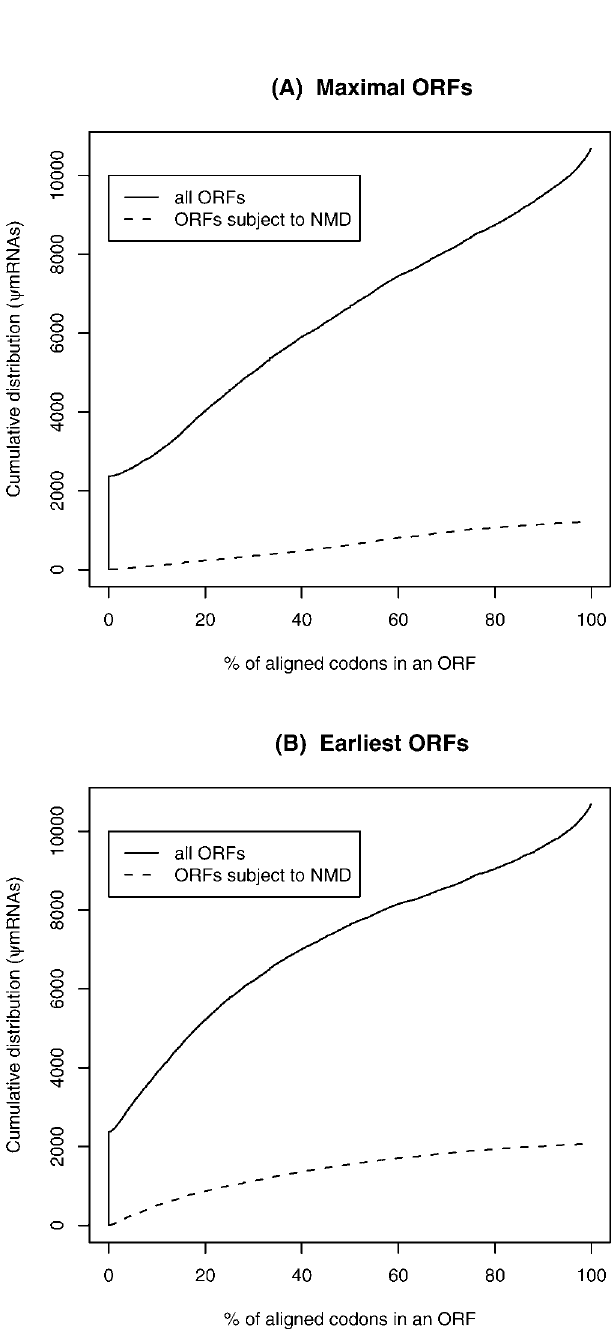
Figure 2. Truncated ORFs of w mRNAs and Potential for NMD We chose either the ORF with the maximal number of codons (A) or the ORF whose in-frame overlap is earliest